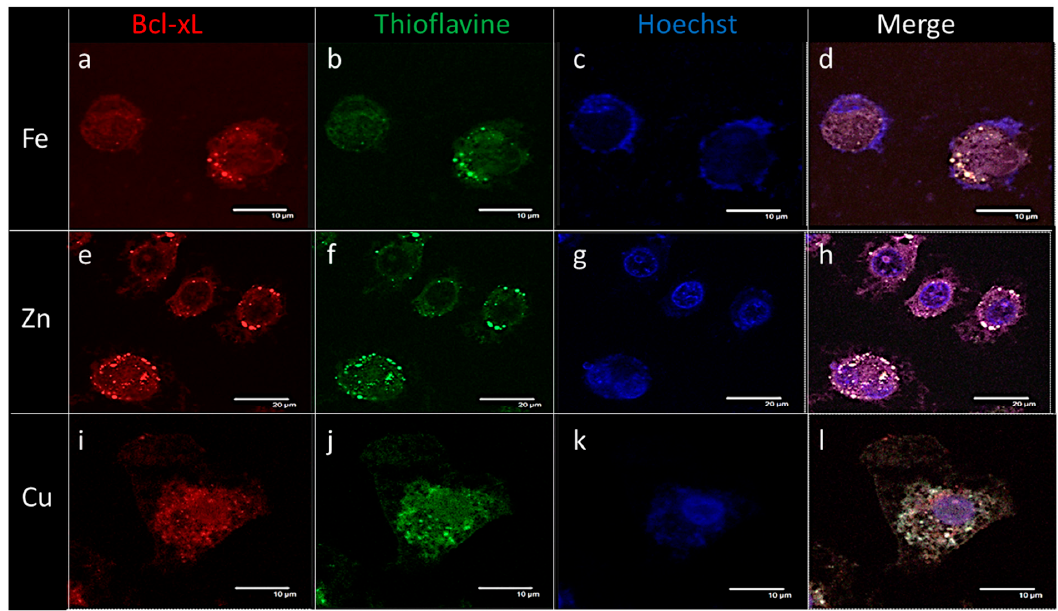
Figure 4. Metal stress-induced intracellular Bcl-xL amyloid deposits in SH-SY5Y: following iron ( a – d ), zinc ( e – h ), and copper ( i – l ) stress, immunostaining with commercial polyclonal anti-Bcl-xL antibodies and Thioflavin-T. Small white arrows indicate the same Bcl-xL aggregates recognized by the monoclonal antibody ( a , e , i ; visualized at 594 nm, red color) and stained with the amyloid dye ( b , f , j ; visualized at 488 nm, green color). Hoechst dye stained the nucleus ( c , g , k ; visualized at 405 nm, blue color). Pictures ( d , h , l ) resulted from the fluorescence merging of the three stains and reveal the co-localization of Bcl-xL aggregates with Thioflavin-T dye (white spots).